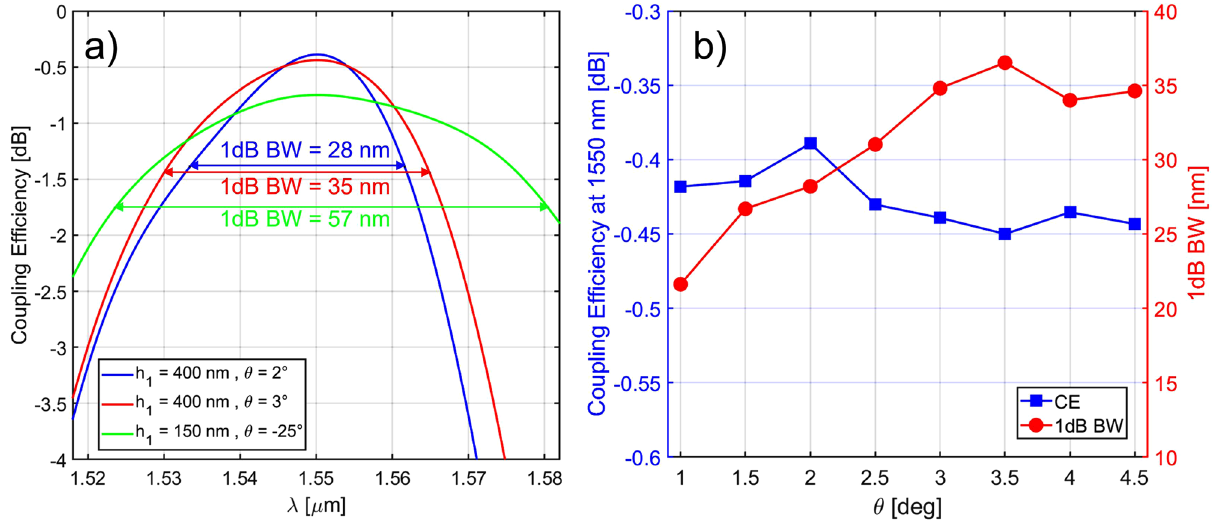
Figure 5. ( a ) Numerically simulated CE as a function of wavelength for dual-level Si–Si 3 N 4 GCs considering 400 nm and 150 nm thick Si 3 N 4 platforms; ( b ) peak CE at 1550 nm and 1 dB BW as a function of the coupling angle θ for dual-level Si–Si 3 N 4 GC for a 400 nm thick Si 3 N 4 platform.